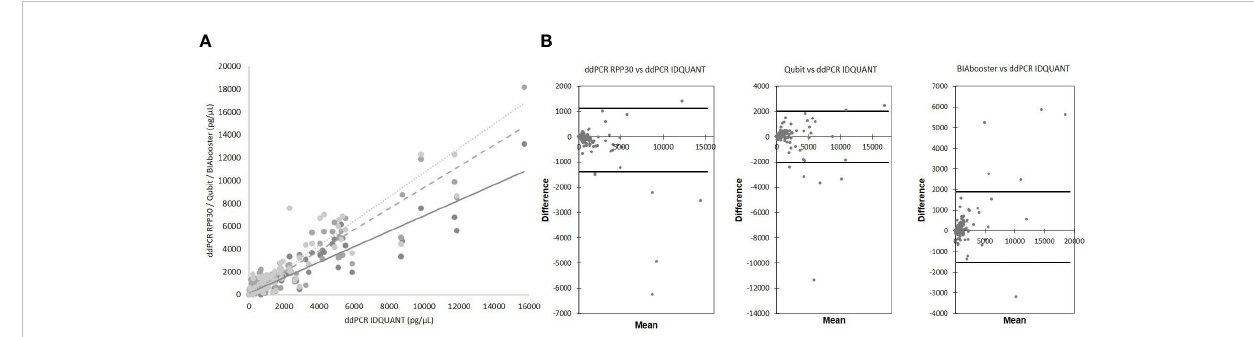
FIGURE 2 Comparison of total cfDNA quanti fi cation techniques. (A) correlation between techniques ddPCR IDQUANT and ddPCR RPP30 (solid line, y = 0.6776x + 127.9; R² = 0.8822, p<0.0001), Qubit (dash line; y = 0.9266x + 137.99; R² = 0.8936, p<0.0001) and BIAbooster (dotted line; y = 1.0656x +